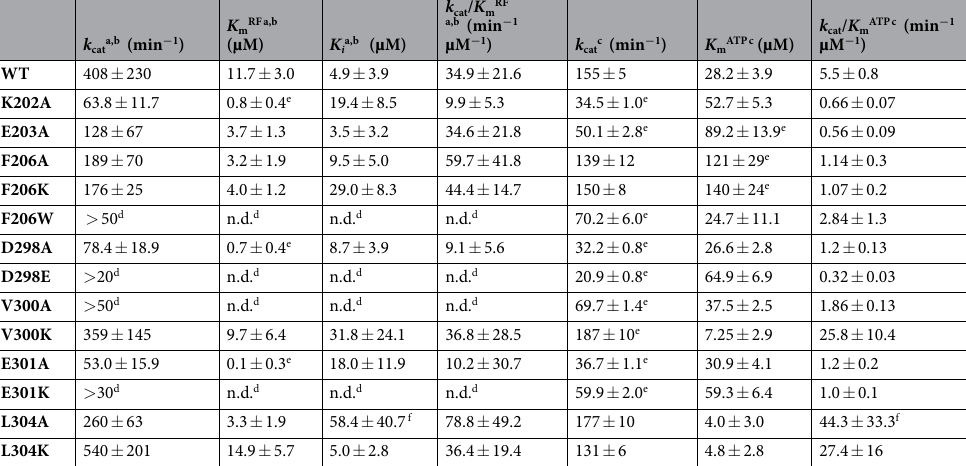
Table 1. Steady-state kinetic parameters for the RFK activity (RF + ATP → FMN + ADP) of the different Ca FADS variants (n = 3; means ± SE). Data obtained at 25 °C in 20 mM PIPES pH 7.0, 0.8 mM MgCl 2 . a Determined at saturating ATP concentrations. b Inhibition by substrate prevented the determination of true parameters and these correspond to apparent constants; app k cat and app K m . Estimated errors in app k cat and app K m values can increase up to ± 35% for the larger K i values. c Parameters estimated using an RF concentration at which ~80% of maximal activity is exhibited. d Despite these variants being active, the high degree of inhibition prevented mathematical determination of their kinetic parameters. e Values showing statistically significant differences, P < 0.002, from the WT, as determined by the one-way ANOVA test (n = 3, confidence interval 95%). f Values showing statistically significant differences, P < 0.02, from the WT, as determined by the one-way ANOVA test (n = 3, confidence interval 95%).